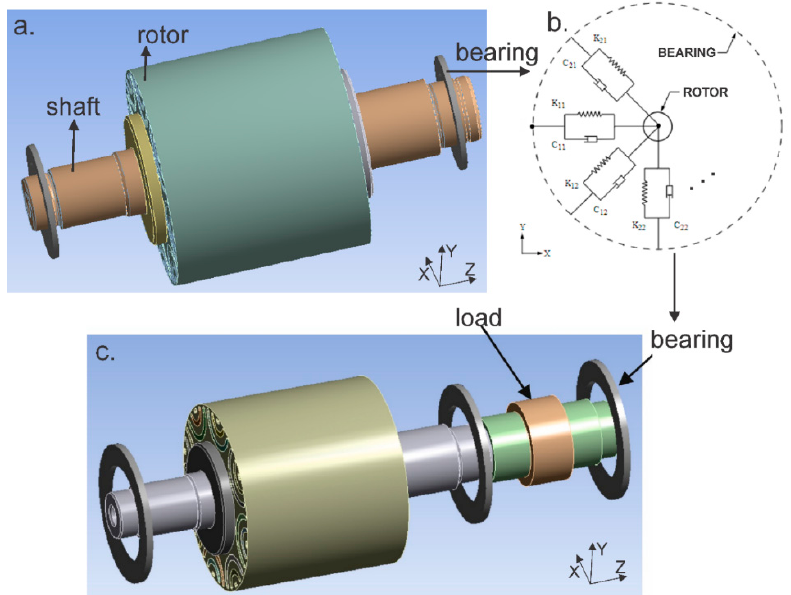
Figure 2. The geometry of the interior permanent magnet IPM motor preprocessed for the numerical rotor dynamic analysis: ( a ) the rotor structure with shaft and the bearings; ( b ) the spring-damper bearing model ( k 11 , k 12 , k 21 , k 22 are the stiffness coefficients and c 11 , c 12 , c 21 , c 22 are the damping coefficients); ( c ) model of the loaded IPM rotor structure with the shaft and the bearings.